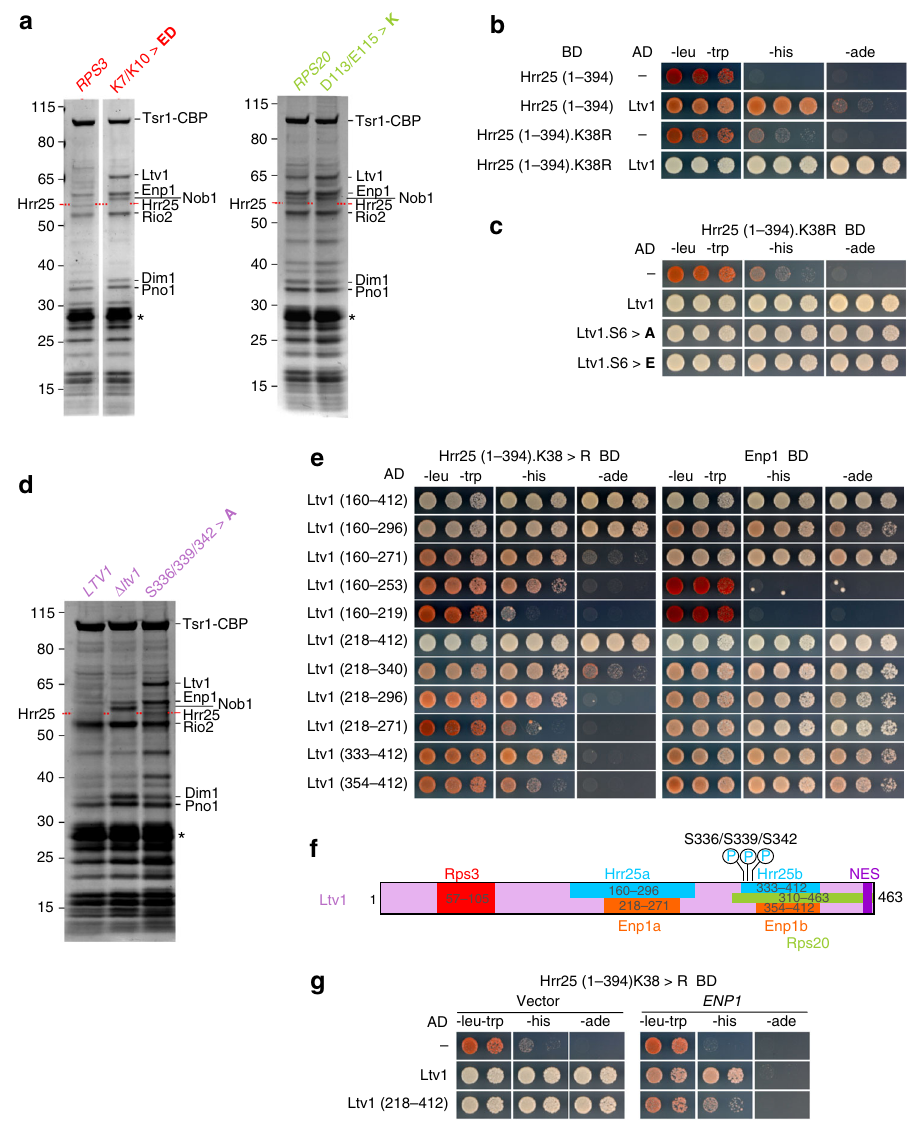
Fig. 1 Rps3 N-domain assembly promotes Hrr25 recruitment. a Reduced binding of Hrr25 to particles impaired in Rps3 N-domain/Rps20 contact formation. Tsr1-TAP particles isolated from wild-type cells or from cells expressing the indicated rps3 or rps20 mutant alleles were analyzed by sodium dodecyl sulfate-polyacrylamide gel electrophoresis (SDS-PAGE) and Coomassie staining. Mass spectrometric (MS) analyses revealed that, while Hrr25 is present on particles isolated from wild-type strains, it is absent or strongly reduced from particles on which the Rps3 N-domain is not assembled (i.e., rps3 . K7/K10> ED and rps20 .D113/E115> K ). Asterisks indicate the band of the Tobacco etch virus (TEV) protease used to elute pre-40S particles from the IgG beads. b , c Characterization of the interaction between Ltv1 and Hrr25. A C-terminal Hrr25 truncation (Hrr25(1 – 394)) and a mutant version thereof